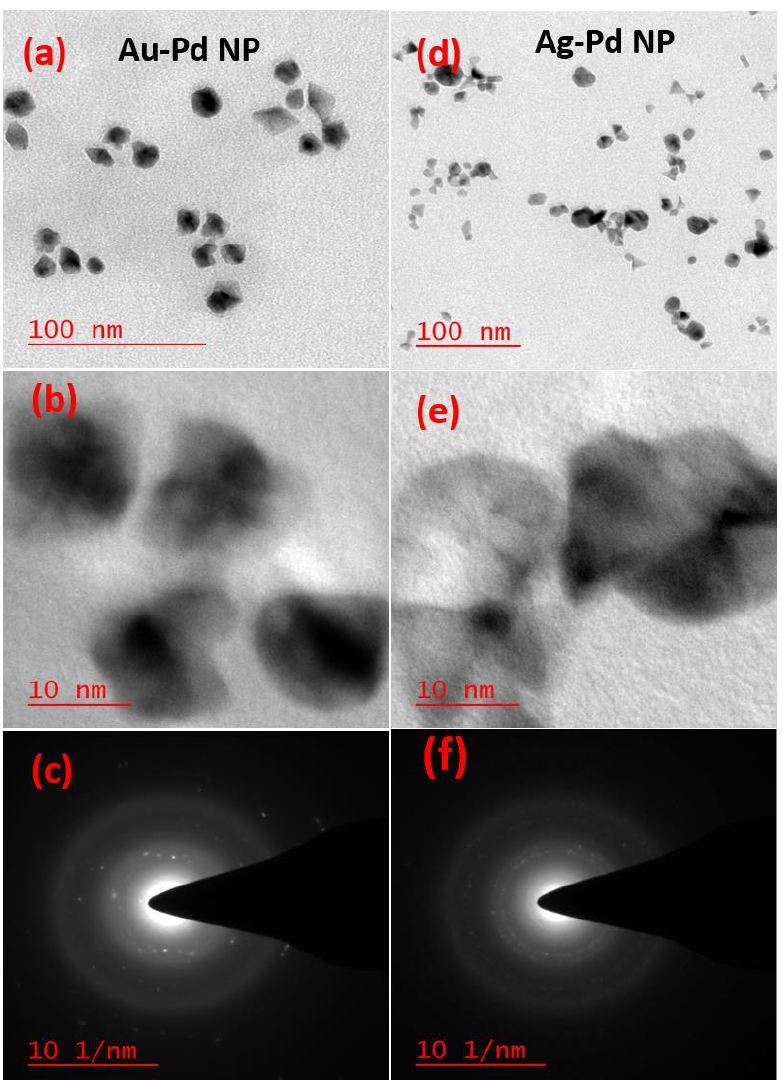
Figure 1. TEM images ( a , b ) and corresponding selected area electron diffraction patter (SAED) patterns of bimetallic (Au-Pd) nanoparticles (NPs) ( c ). TEM images ( d , e ) and corresponding SAED patterns of bimetallic (Au-Pd) NPs ( f